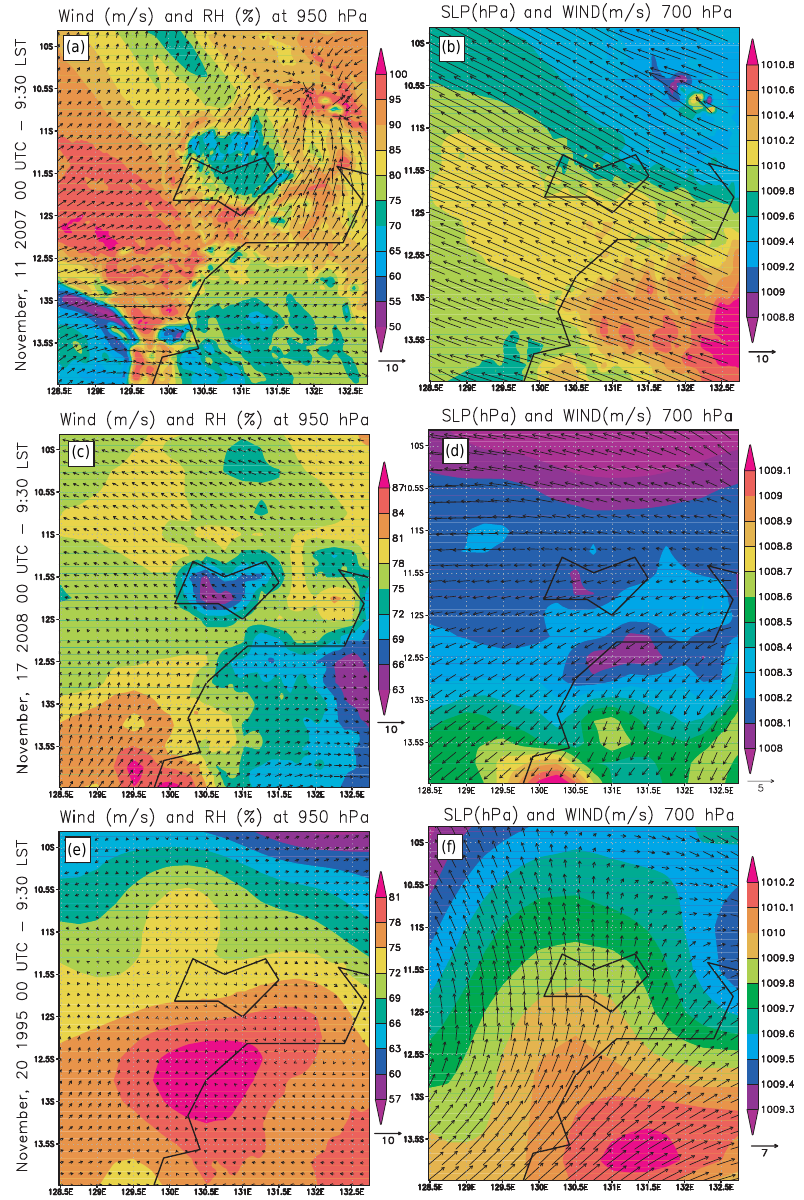
Figure 2. ECMWF analysis over the Tiwi Islands at 00:00UTC for N11, N17 and N20. Panels (a, c, e) report surface wind and relative humidity at 950hPa; panels (b, d, f) report sea level pressure in filled contours and wind flow vectors at